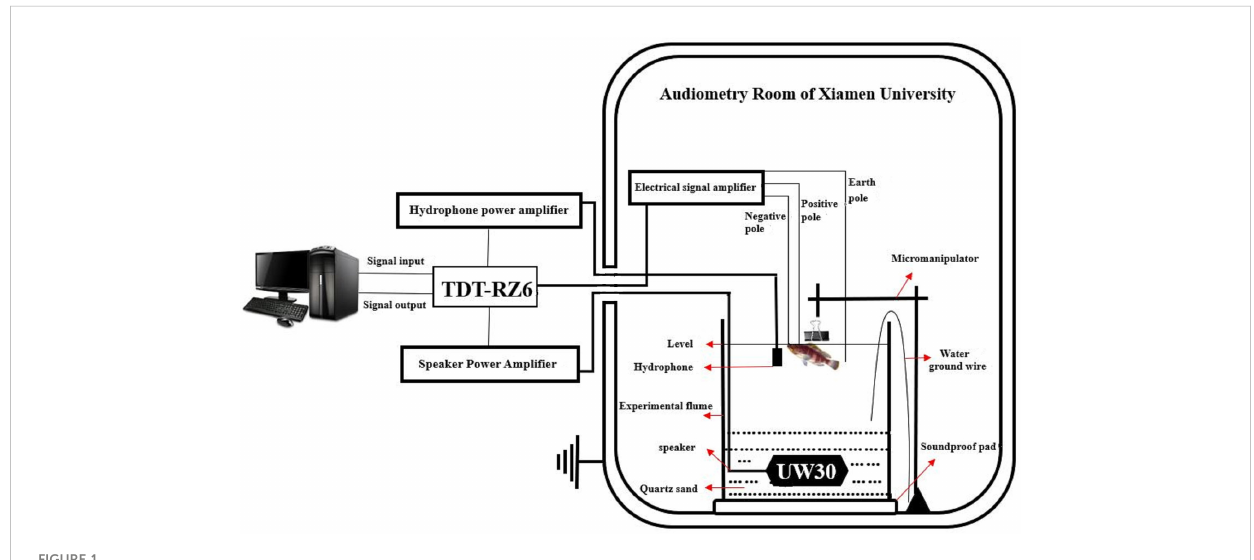
FIGURE 1 Auditory threshold detection system.